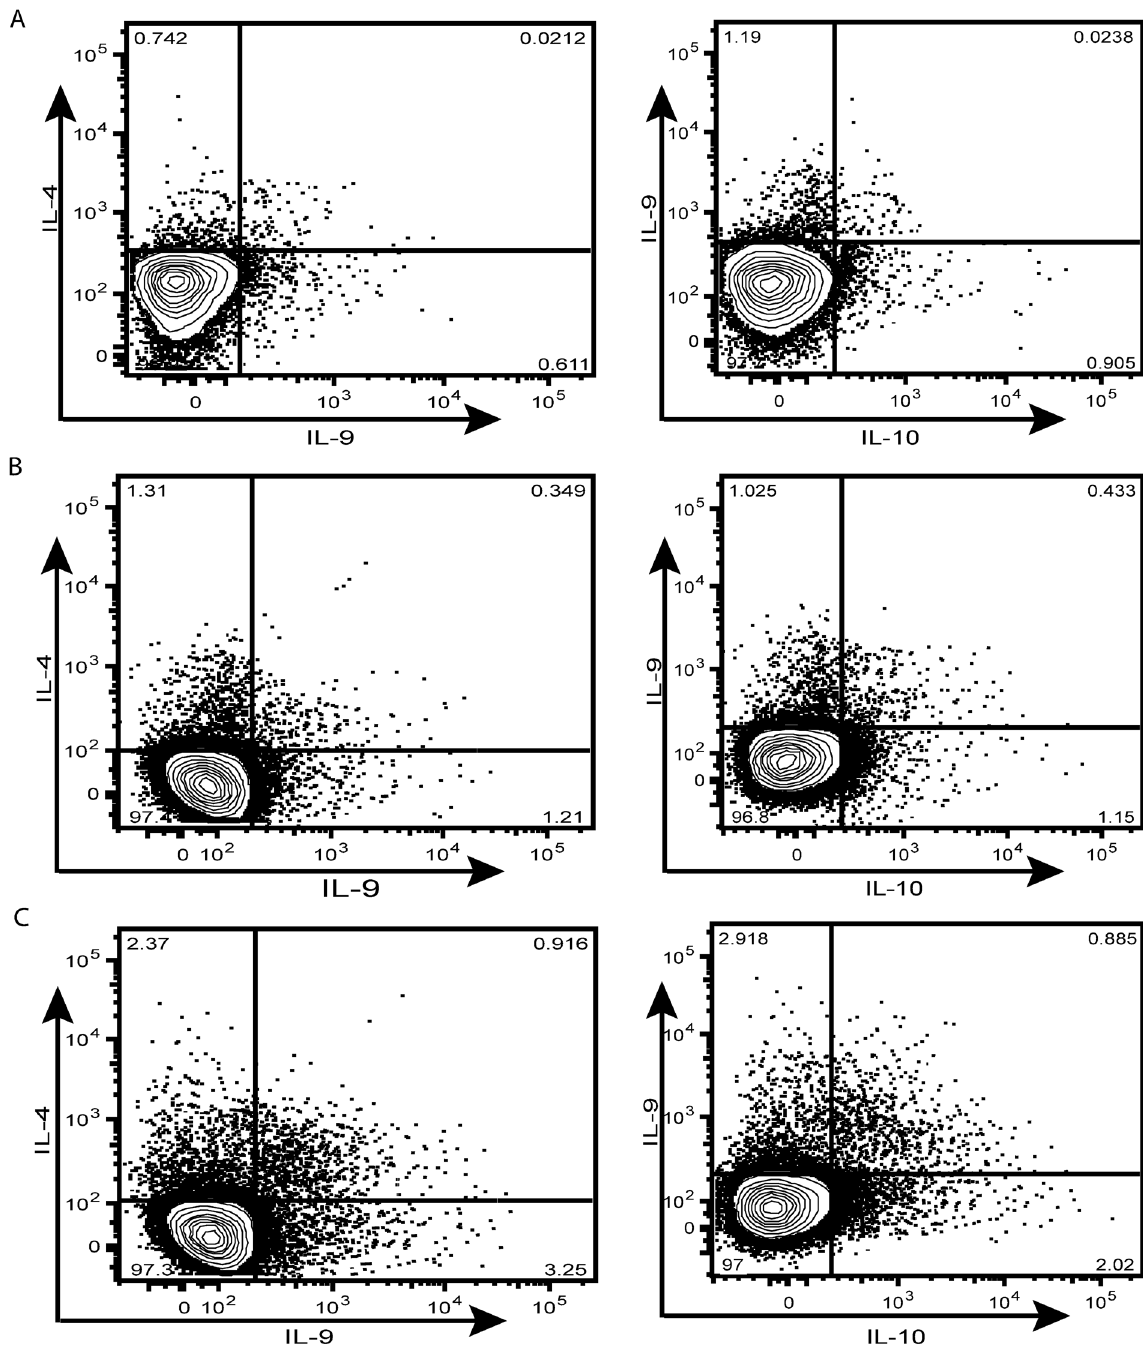
Fig 1. Strongyloides infection is associated with expansion of mono- and dual-functional Th9 cells. Whole blood was cultured with media alone for 6 h and the baseline and antigen-specific frequencies of Th9 cells determined. A representative whole-blood intracellular cytokine assay flow data from a INF individual showing expression of IL-9, IL-4 and IL-10 at baseline (A) and following stimulation with SsAg (B) or P/I (C). The plots shown are gated on CD3 + CD4 + T cells.